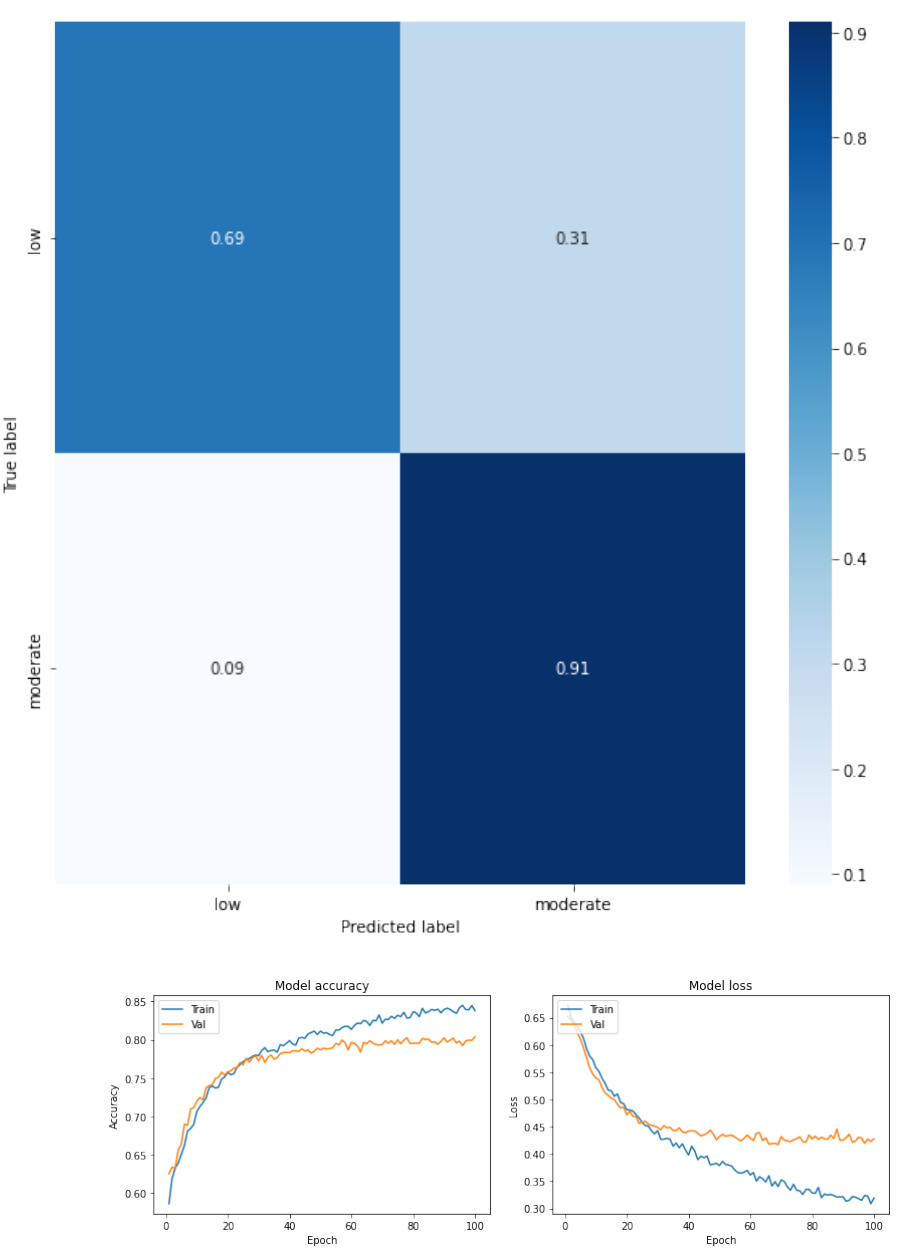
Figure 6. Confusion matrix, accuracy, and loss function for the total dataset for two levels of FOF (low vs. moderate). Table 8. Performance metrics for two classes of FOF (low vs. moderate for the total dataset).